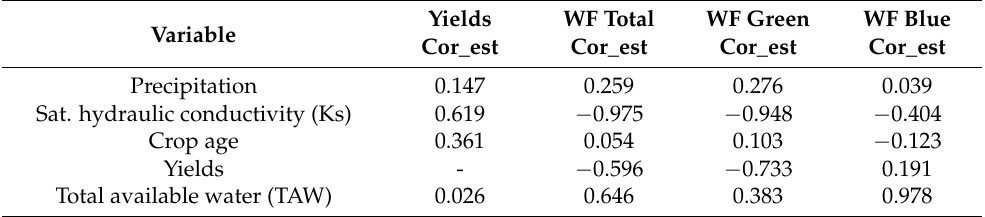
Table 5. Variable correlations with water with total, green, and blue footprint. WF: water